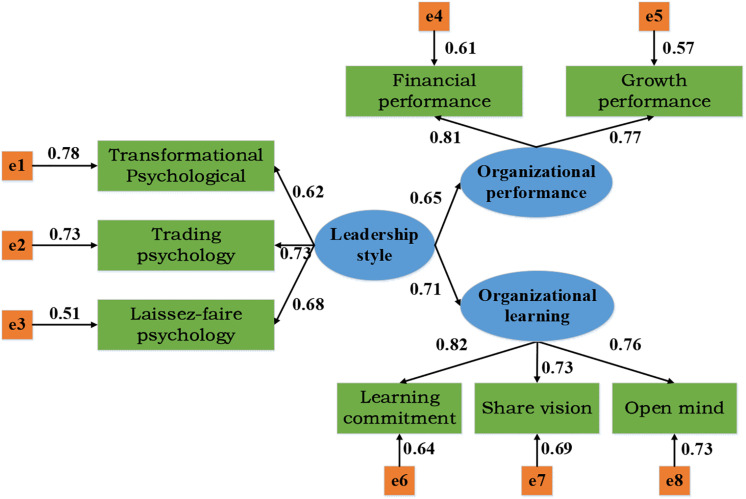
The structural equation path analysis of the relationship model between the different entrepreneurial psychological leadership styles, organizational learning ability, and organizational performance.